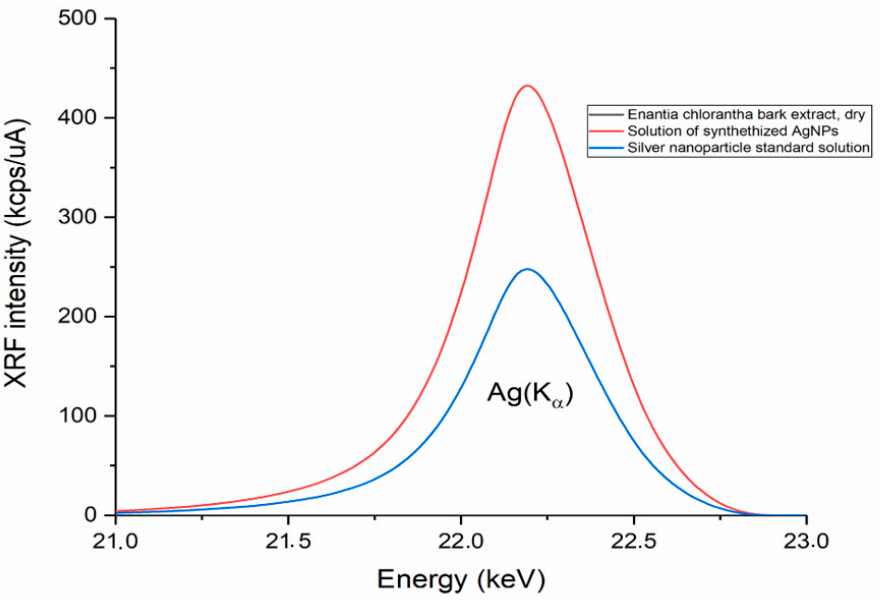
Figure 3. XRF spectra of dry Enantia chlorantha bark extract (black) and solutions of green- synthesized AgNPs (red) and silver nanoparticle standard (blue) with the characteristic energy of silver fluorescence—silver K α line of 22.105